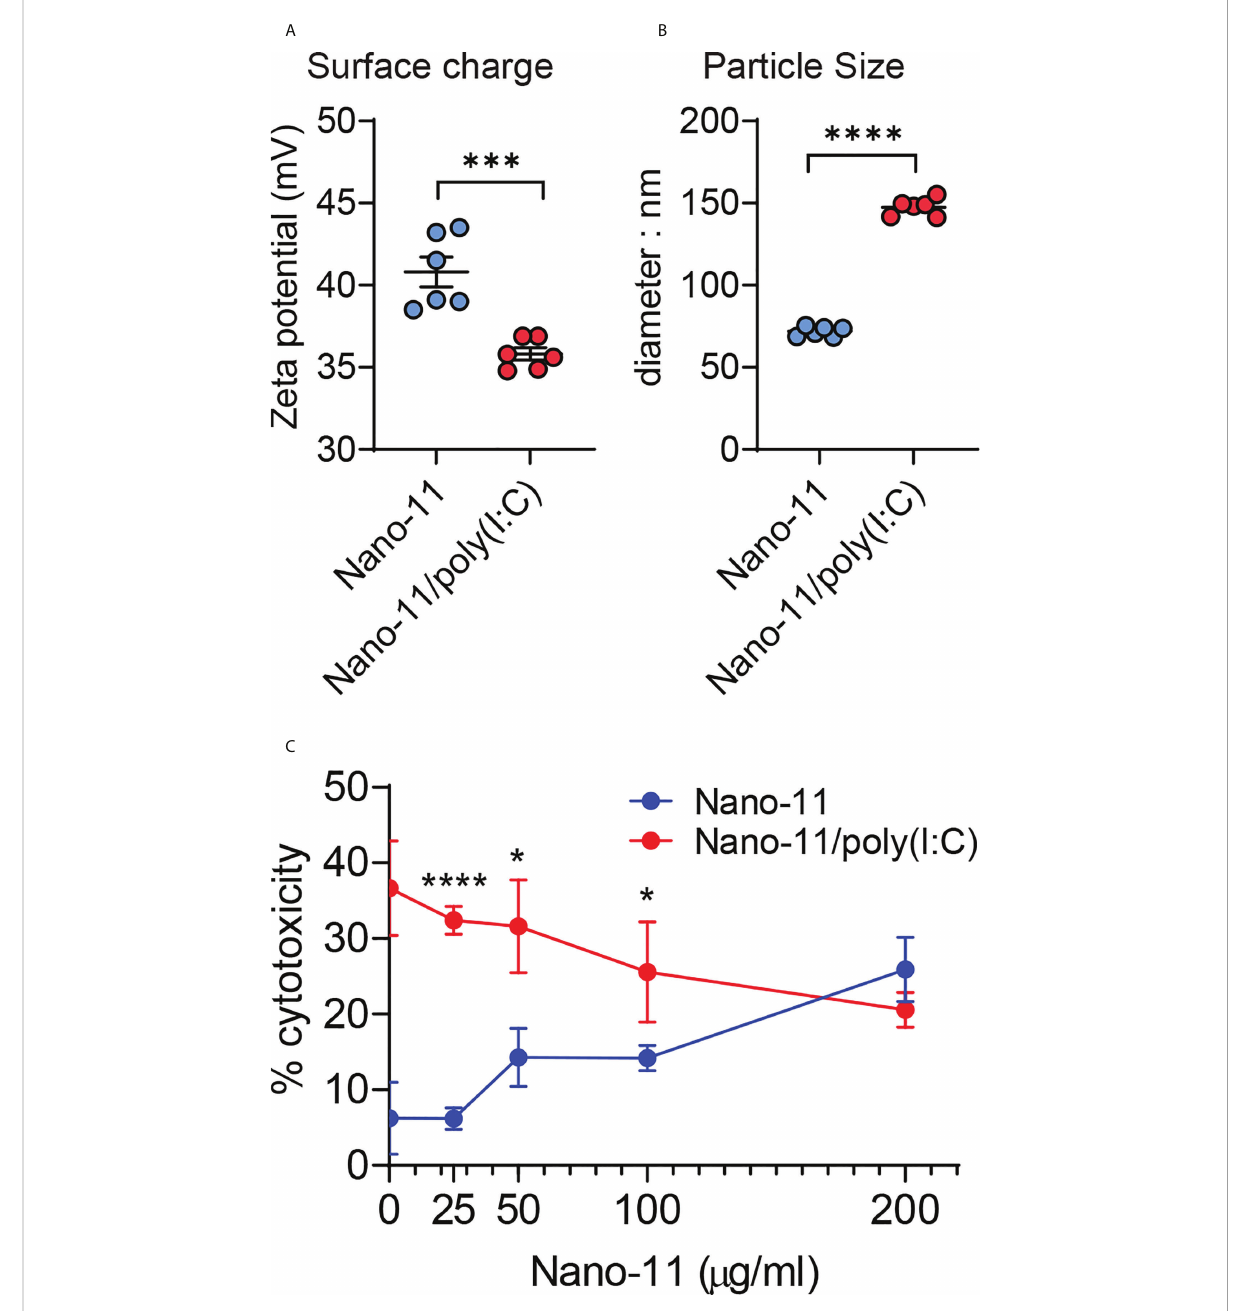
FIGURE 1 Physicochemical properties and cytotoxicity of Nano-11 and Nano-11/poly(I:C). (A) Zeta potential of Nano-11 and Nano-11/poly(I:C). (B) Particle size (diameter) of Nano-11 and Nano-11/poly(I:C). (C) Cytotoxicity was determined by the release of LDH from porcine Mo-DCs treated for 48 hours with Nano-11 at the indicated concentrations and combined with 40 ug/ml poly(I:C). The bars indicate the mean ± SE of three replicates. Results are representative of two independent experiments. *p < 0.05, ***p < 0.001, ****p <